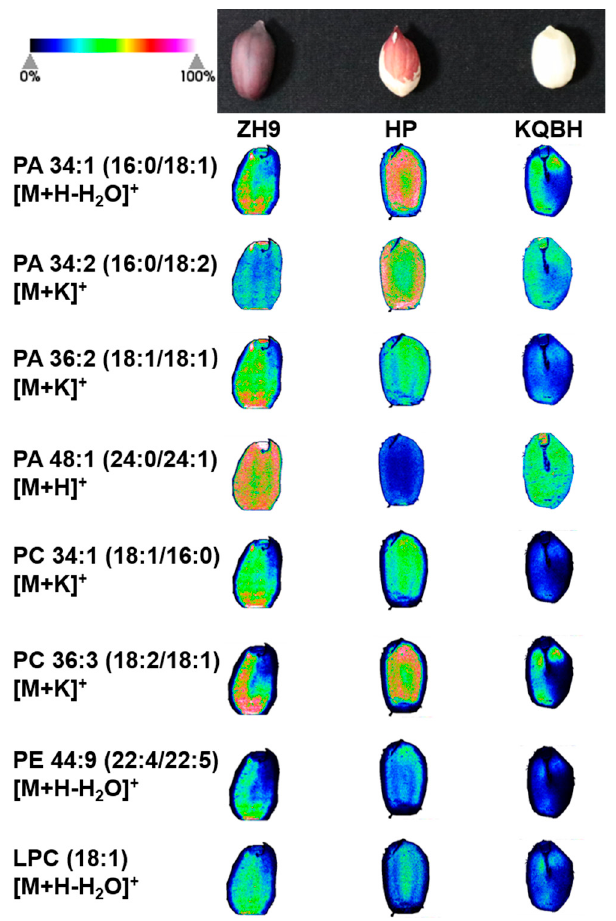
Figure 4. MALDI-MSI of representative glycerophospholipids in different peanut seeds. The left column shows the names of phosphatidic acids (PAs), phosphatidylcholines (PCs), lysophosphatidylcholine (LPC), and phosphatidylethanolamine (PE). The green (minimum) to red (maximum) scale indicates ion intensity for each lipid species determined by mass spectrometry. For the same glycerophospholipid molecules, signal range was normalized at the same level.